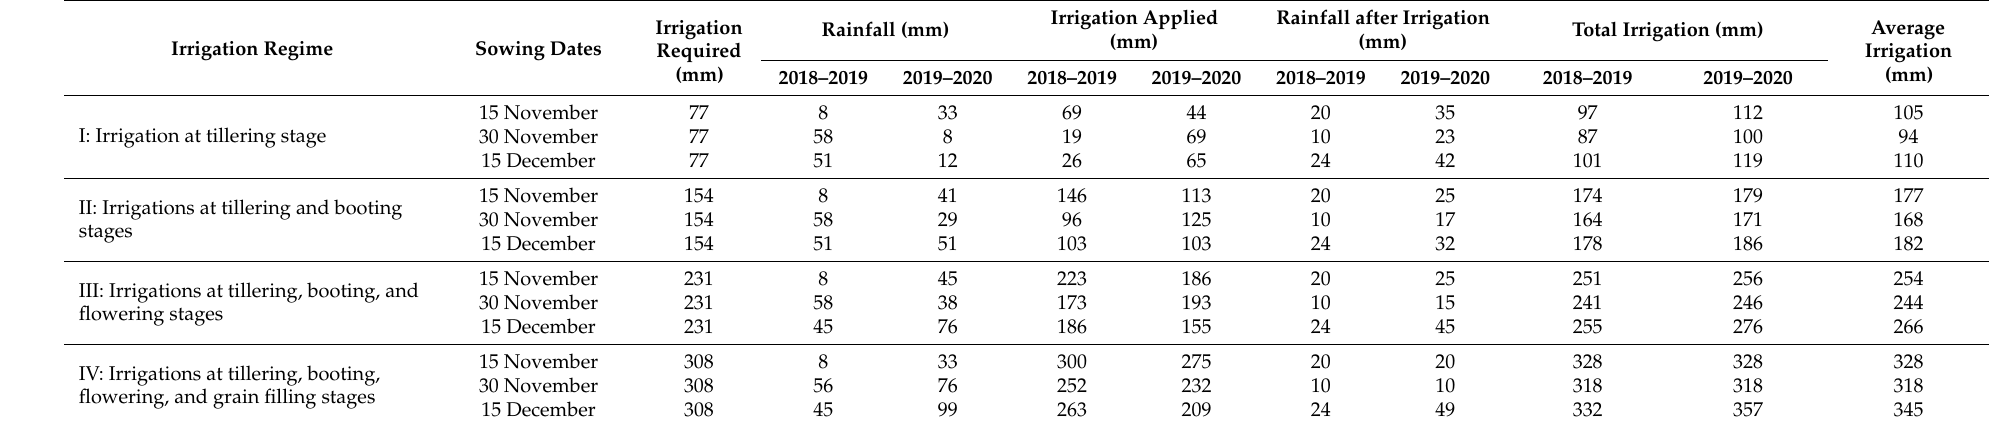
Table 2. Breakdown of the irrigation provided under different moisture regimes and sowing